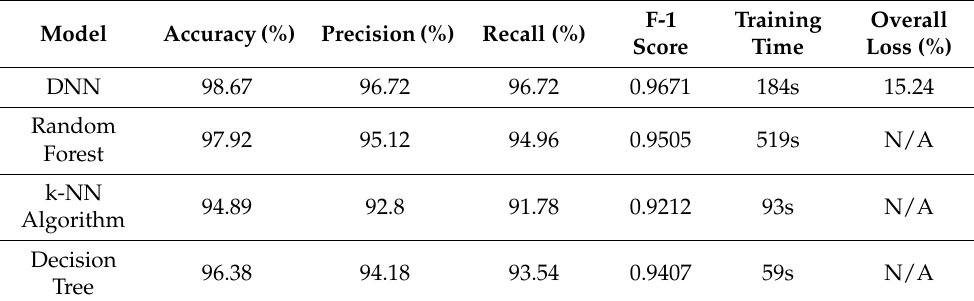
Table 8. Performance comparison with other standard